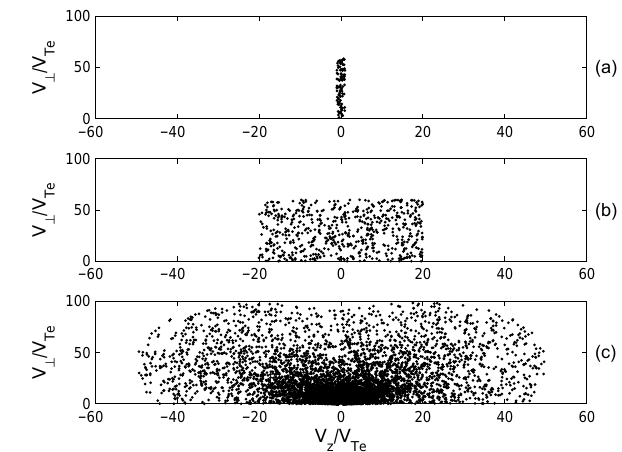
Figure 1. Schematic diagram for pancake-like (a) , tablet-like (b) , and smooth (c) distributions in the velocity space ( V ⊥ , V z